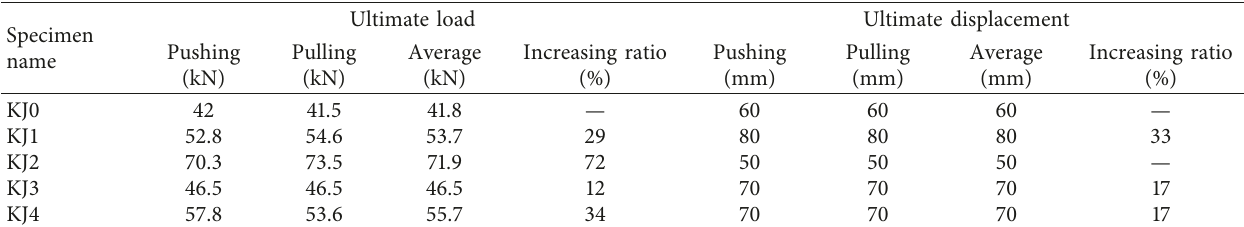
Table 3: Values of the ultimate load and ultimate displacement of the tested